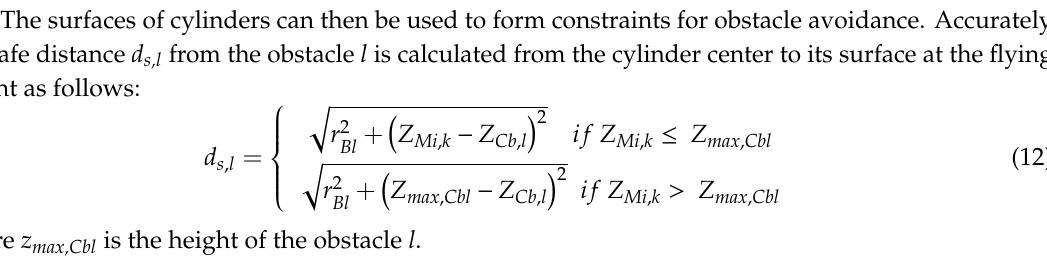
Figure 7. Obstacle representation and safe distance calculation.